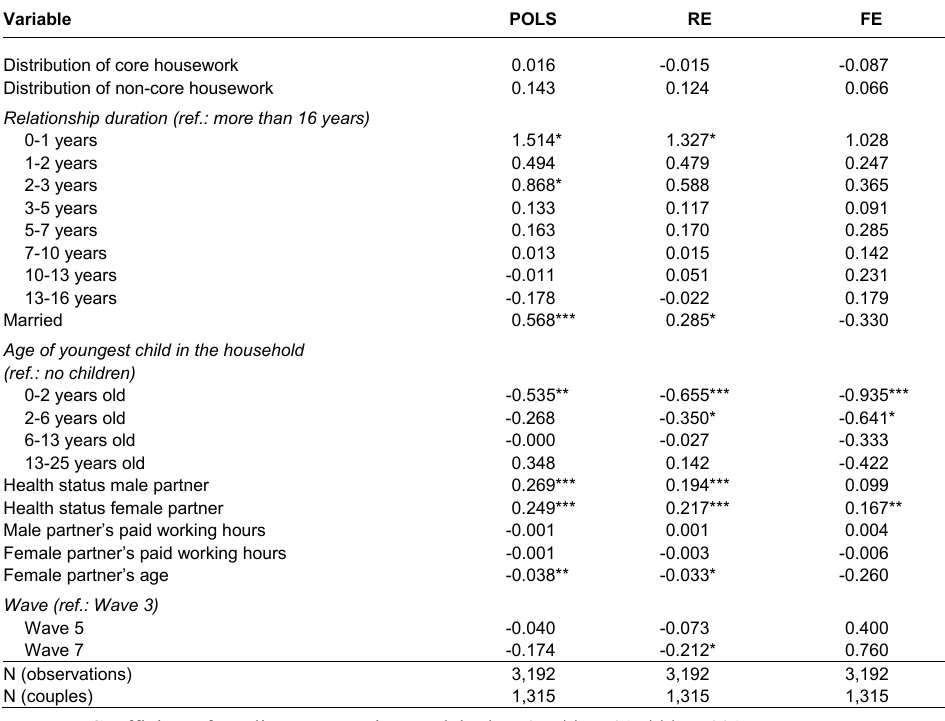
Summary of pooled OLS (POLS), random (RE), and fixed effects (FE) regression analyses estimating sexual